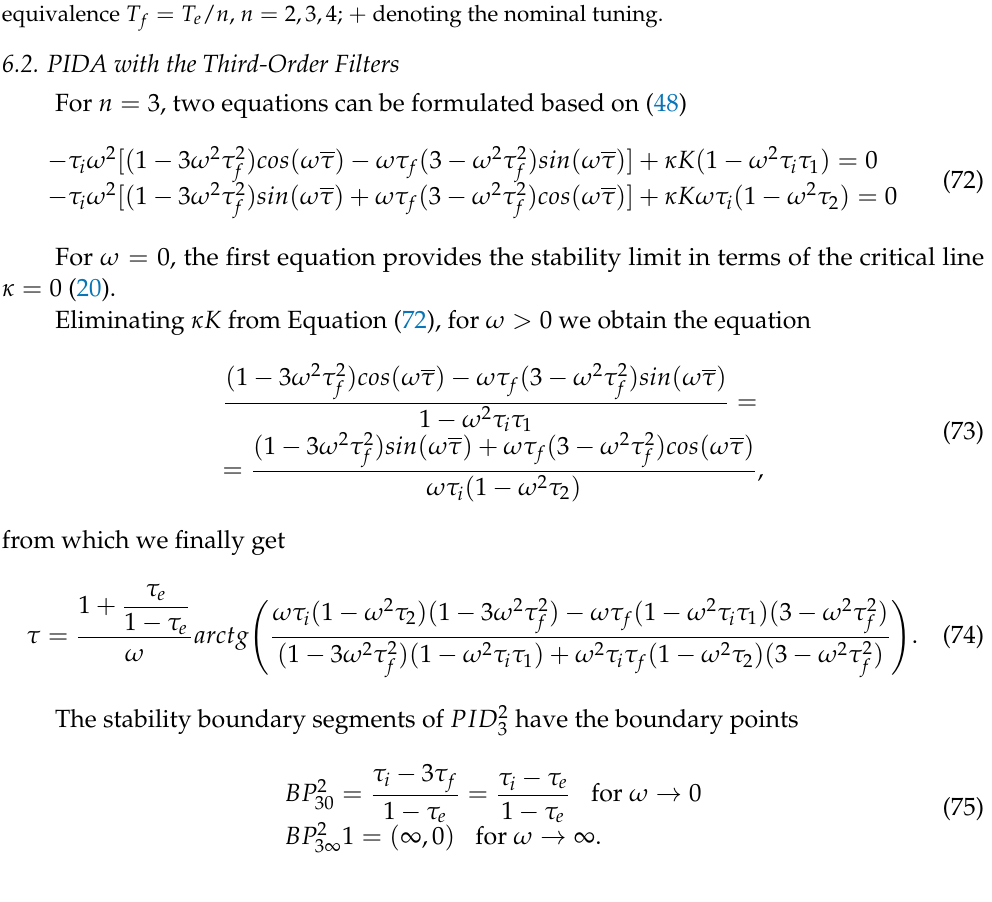
Figure 10. Stability borders of the nonfiltered PI ( PID 0 and PID 2 ) for several values of τ e = T e / ( T dp + T e ) , T dp = 1 and the average-residence-time tuning 4 equivalence T f = T e / n , n = 2,3,4; + denoting the nominal